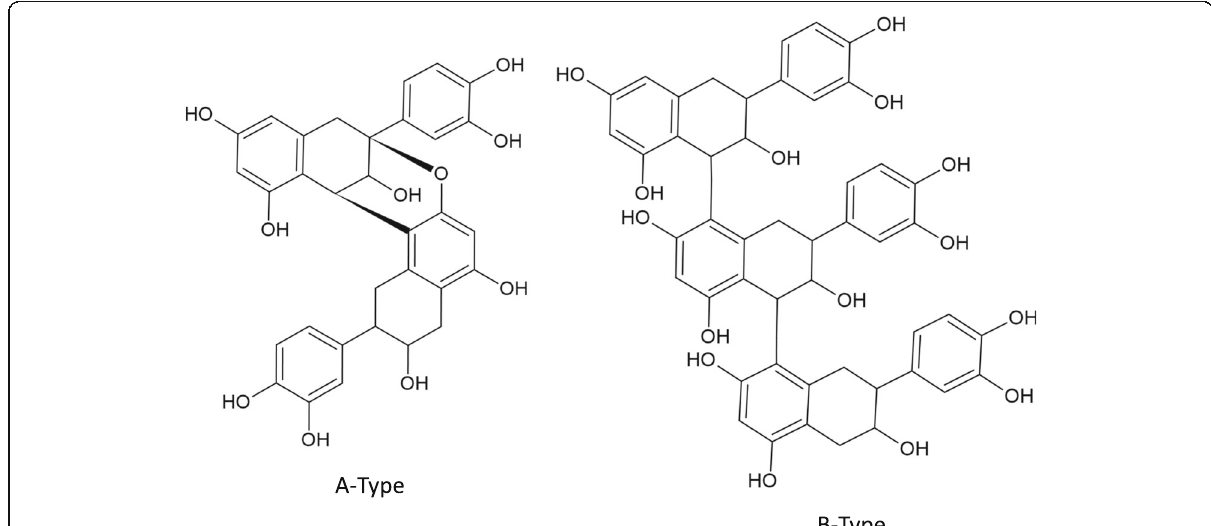
Fig. 2 Chemical structure of proanthocyanidins (PAC), showing the two possible types of bonds between flavan-3-ol monomers and two degrees of polymerization: type A dimer and type B